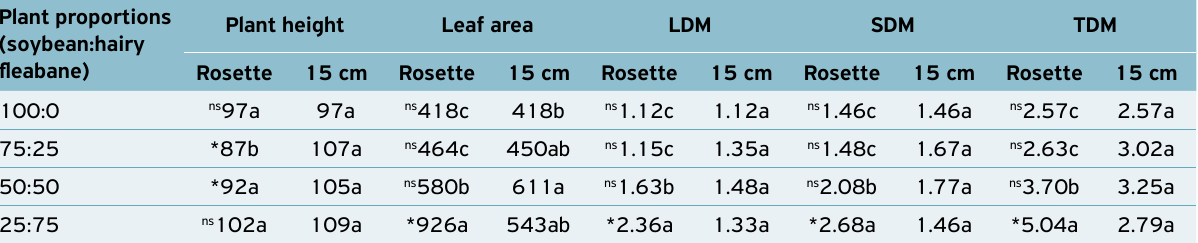
Table 2. Plant height (H), leaf area (LA), leaf dry matter (LDM), stem dry matter (SDM) and total dry matter (TDM) in different proportions of soybean and hairy fleabane of different growth stages (rosette and 15 cm tall).